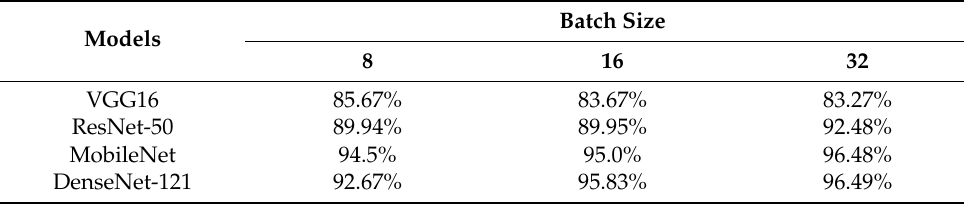
Table 8. Test accuracies based on batch sizes.